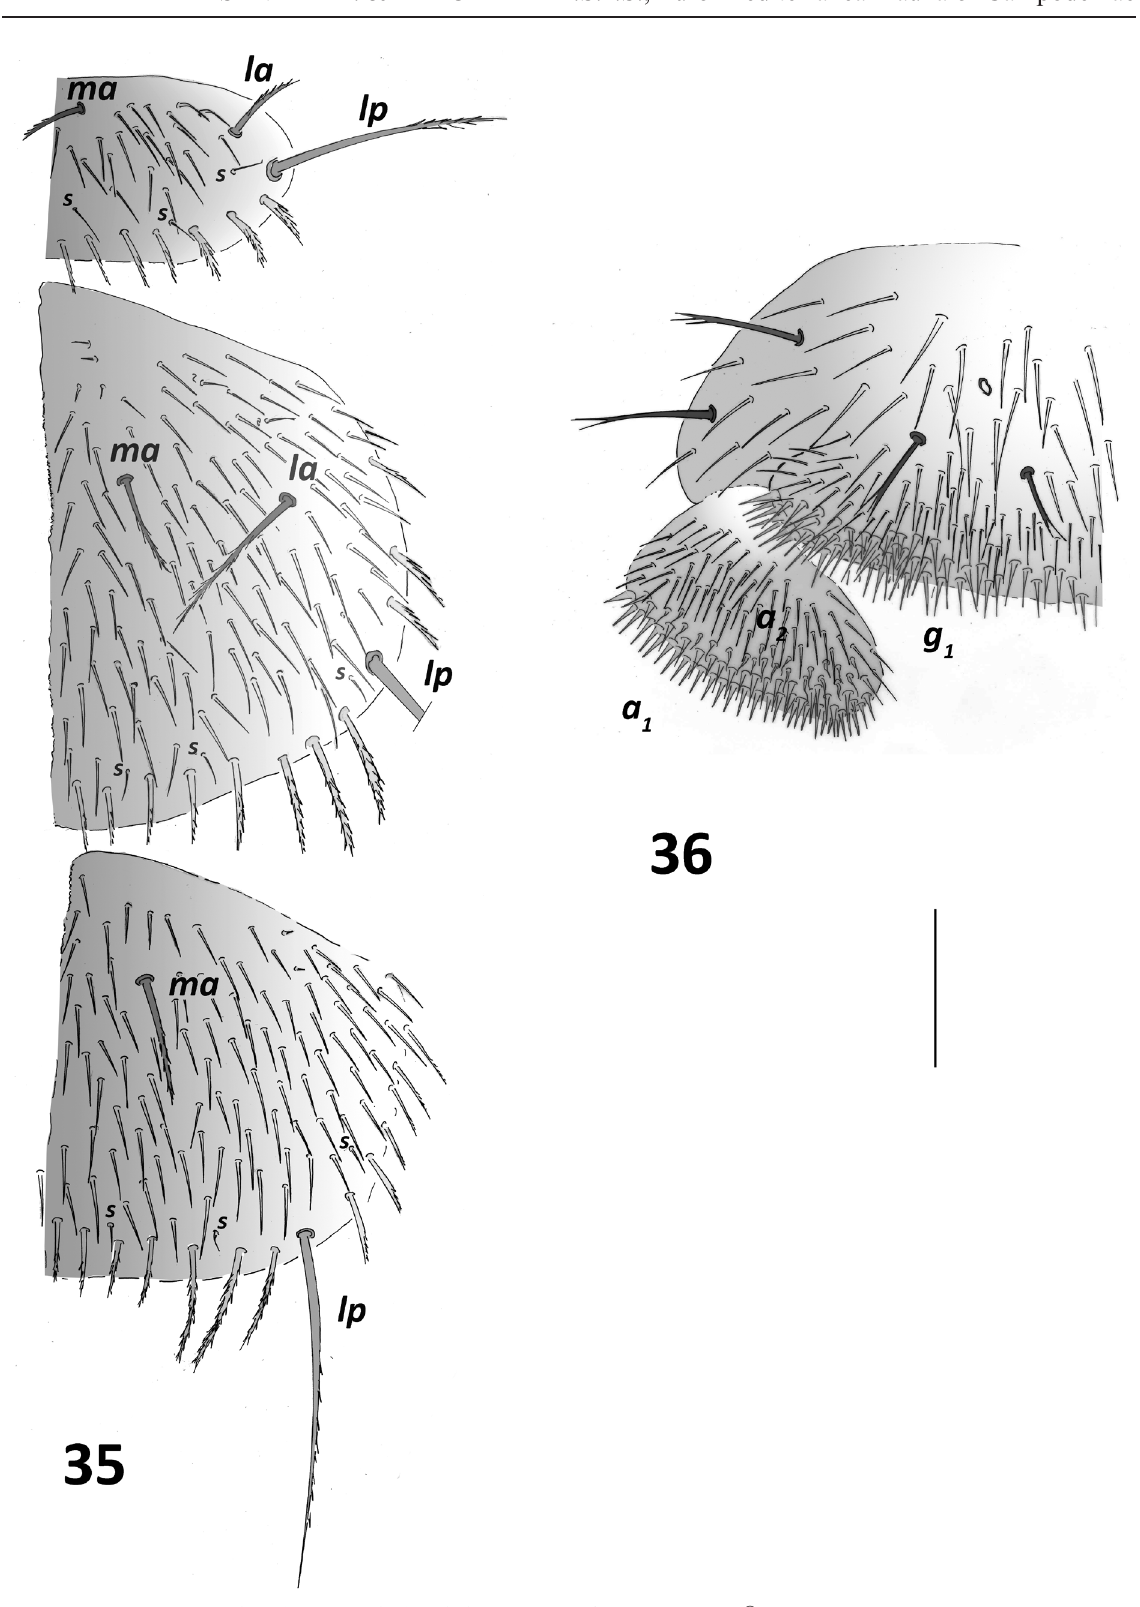
Figs 35–36. Campodea ( Campodea ) ghilarovi Rusek, 1965. 35 . ♀, 2.5 mm, pronotum, mesonotum and metanotum, right side, from Abkhazia. 36 . ♂, 2.8 mm, first urosternite, right side, from Abkhazia. Abbreviations: a , a , g = glandular setae; see Material and methods. Scale bar: 0.1 1 2 1